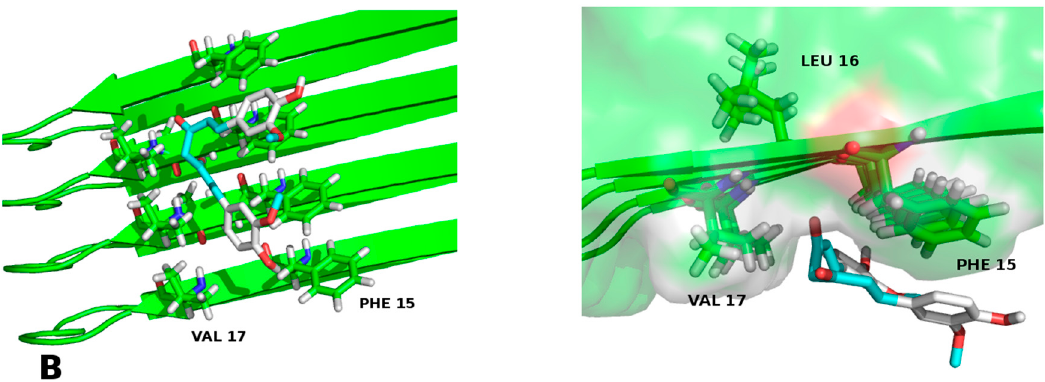
Figure 4. ( A ) Curcumin–hIAPP 1–37 interaction; ( B ) Curcumin–Amylin fibrils (4 monomers) interaction. The similitude of the amino acids that participate in the protein-ligand interaction is to be noted. They are the same as those in the interaction of the pharmaco-chaperone A and E .